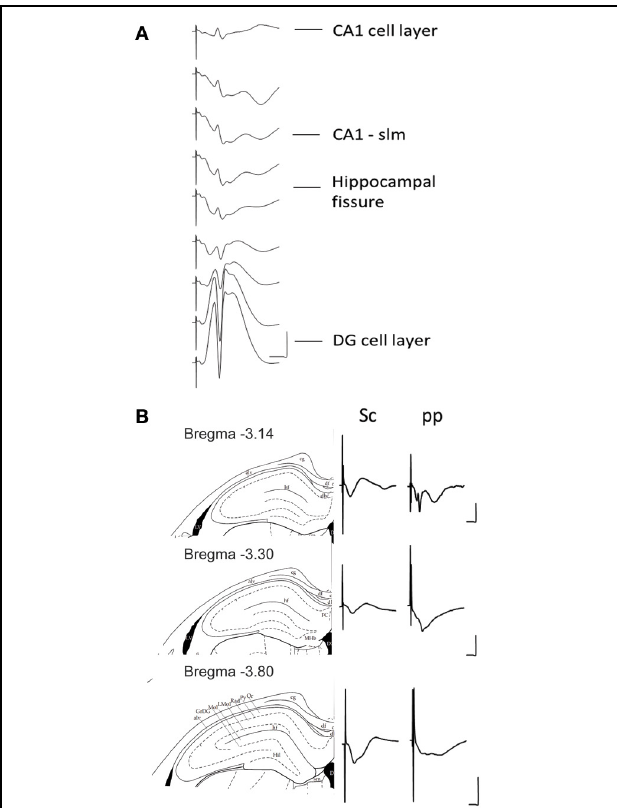
FIGURE 2 | (A) Depth profile of evoked potentials as a result of perforant path stimulation. Example of typical field responses in vivo evoked by perforant path stimulation. The recordings started at the granule cell layer of the dentate gyrus (DG). The depth was decreased stepwise at 5min intervals progressing “backwards” to the CA1 region. The distance between each representative recording was 160 μ m. The stimulation intensity for all recordings was 200 μ A. Vertical scale bar: 5mV, horizontal scale bar: 3ms. (B) Evoked potentials at the CA1-stratum lacunosum moleculare synapse in response to Schaffer collateral and perforant path stimulation. Examples of typically evoked responses in vivo at the CA1-slm as a result of Schaffer collateral (analogs on the left) and perforant path stimulation (analogs traces on the right) at three different anterioposterior coordinates. The diagrams to the left of the analog traces represent coronal sections of hippocampal formation − 3.14mm (Top), − 3.30mm (middle), and − 3.80mm (bottom) from bregma (Paxinos and Watson, 1998). The histological examination of the recording site was depicted as a dot on the corresponding slide (Paxinos and Watson, 1998). All of the recordings were taken from freely behaving rats. The stimulation intensity for all recordings was 200 μ A. Vertical scale bar: 5mV, horizontal scale bar: 5ms for all traces. alv, alveus of the hippocampus; cg, cingulum; df, dorsal fornix; FC, fasciola cinereun; GrDG, granular layer of the dentate gyrus; hf, hippocampal fissure; Hil, hilus of the dentate gyrus; LMol, lacunosum moleculare layer of the hippocampus; Mol, molecular layer of the dentate gyrus; Or, oriens layer of the hippocampus; Py, pyramidal cell layer of the hippocampus; Rad, stratum radiatum of the hippocampus.